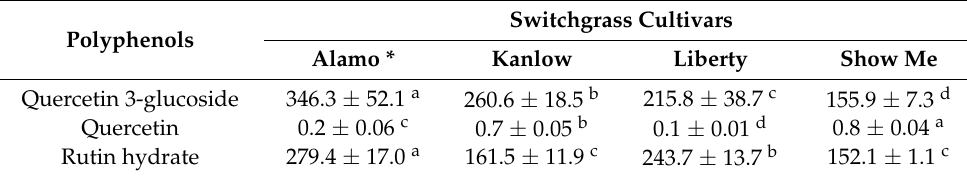
Table 3. Amounts of anti-inflammatory compounds (mg/kg) in switchgrass determined by UPLC-